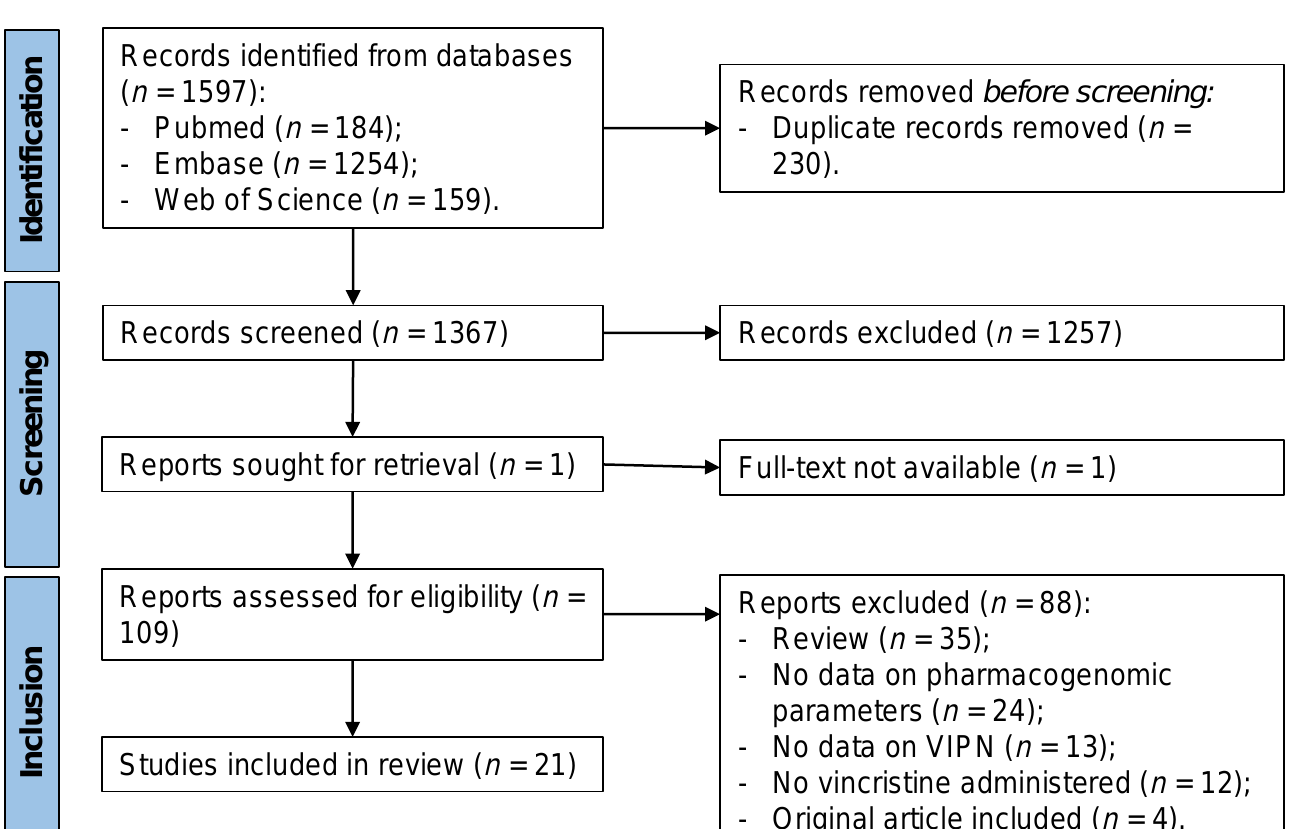
Figure 1. PRISMA flow diagram identification of studies included in the systematic review. VIPN = vincristine-induced peripheral